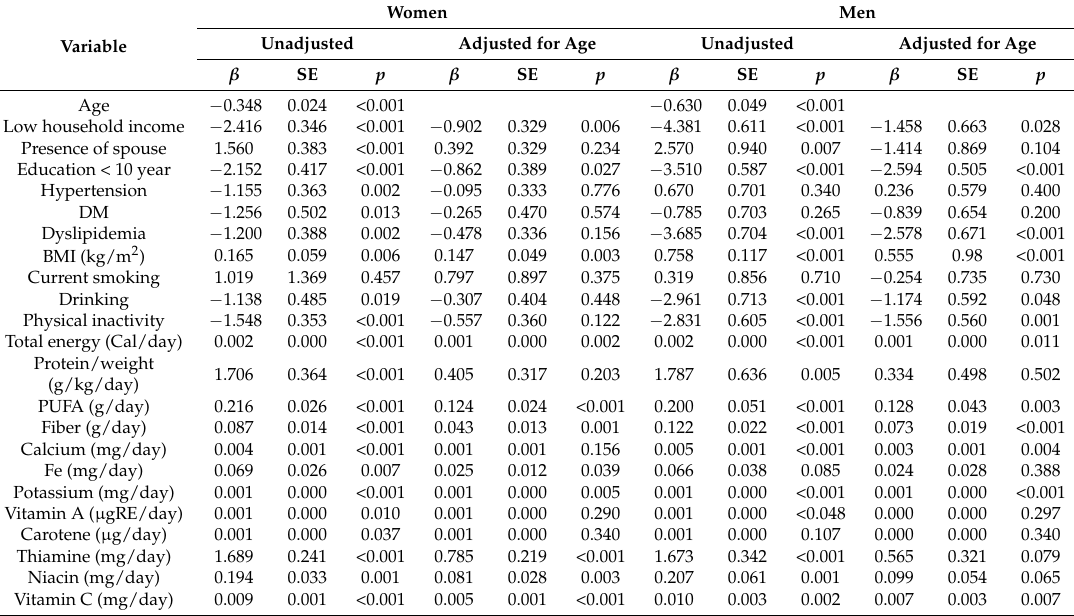
Table 4. Handgrip strength and clinical characteristics, nutritional status.